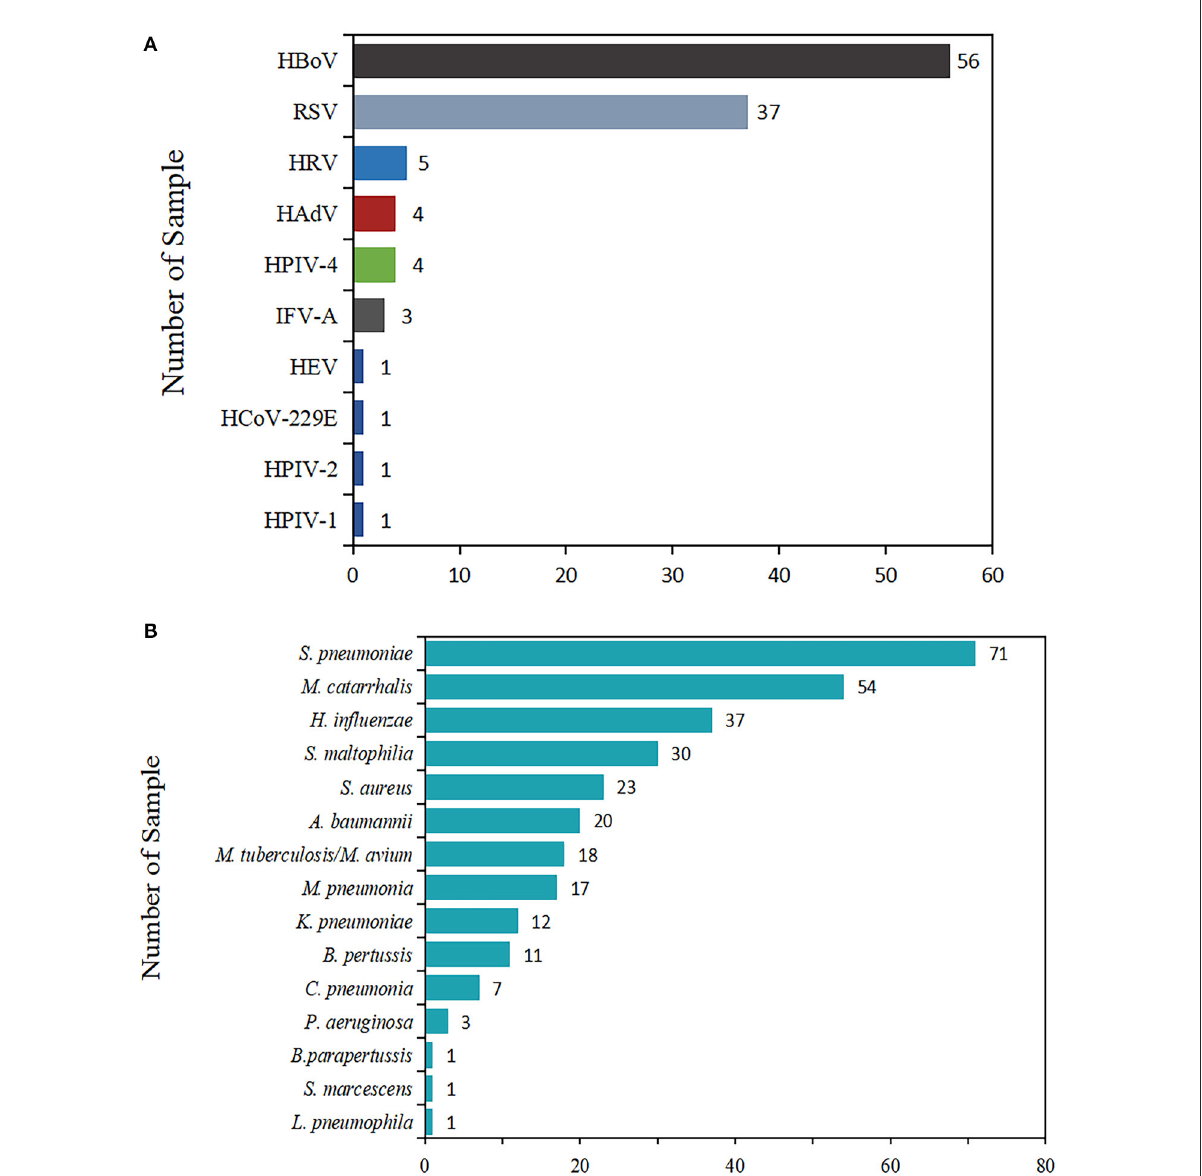
FIGURE1 Total number of viruses and bacteria detected in children with ARIs. The length of the color bar and the number marked behind are the number of pathogens detected. (A) The detection of viruses. (B) The detection of bacteria.